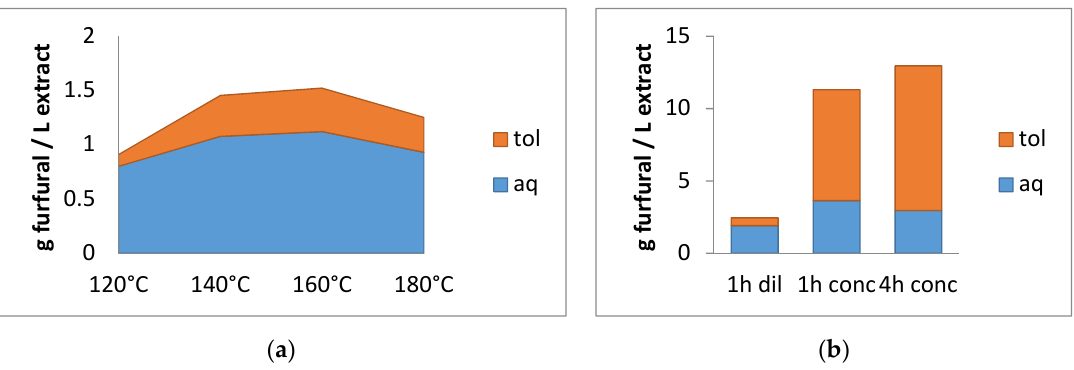
Figure 6. ( a ) Effect of the reaction temperature, and ( b ) effect of the concentration of the xylose extract Figure 6. ( a ) E ff ect of the reaction temperature, and ( b ) e ff ect of the concentration of the xylose extract and reaction time on the production of furfural using H- β zeolite catalyst. and reaction time on the production of furfural using H- β zeolite